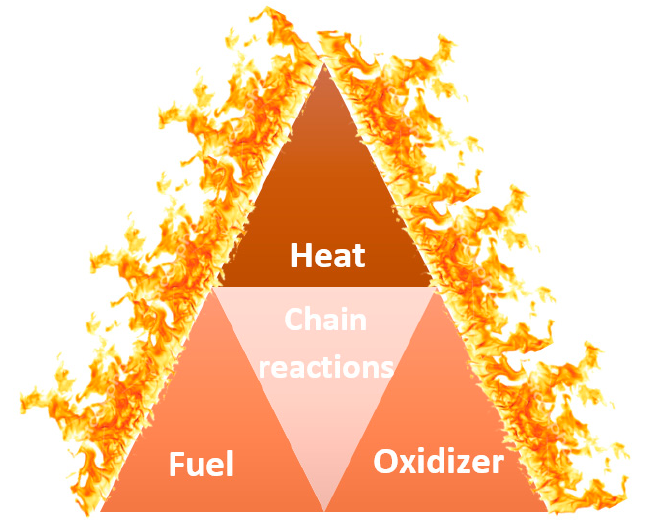
Figure 2. A fire tetrahedron [29].